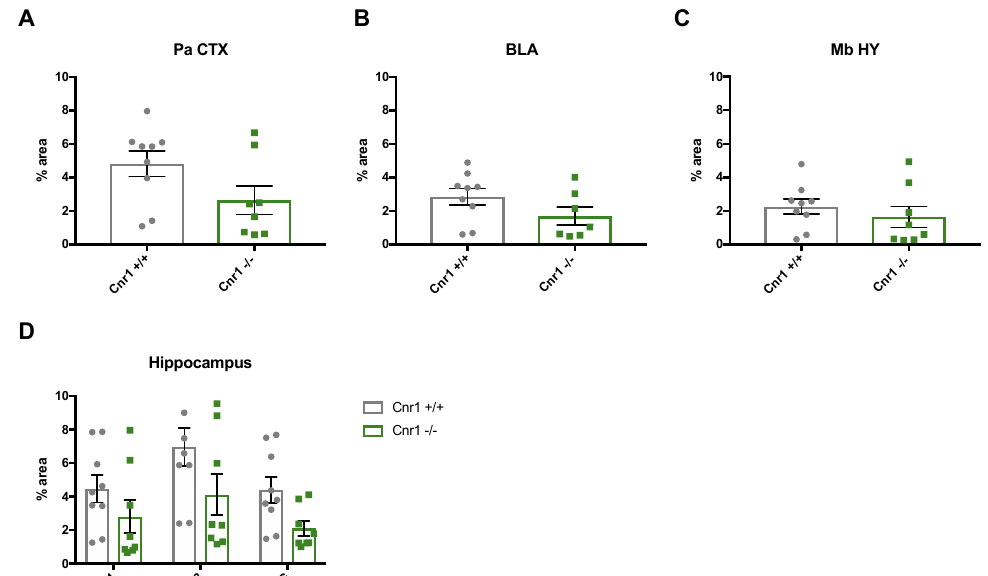
Figure 4. Analysis of the density of adrenergic axon terminals are covered by NET-positive signal intensity in the parietal cortex (Pa CTX), basolateral amygdala (BLA), mediobasal hypothalamus (Mb HY) and hippocampal cornu ammonis 1 (CA1), cornu ammonis 3 (CA3), and dentate gyrus (DG) regions of 18-month old Cnr1 +/+ and Cnr1 − / − animals. N = 7–9 per genotype; Dots represent single animals, columns represent mean values, error bars represent standard error of means (SEM). The density of the NET-positive signal differed significantly between the target re- gions (F (5,75) = 5.964; p = 0.0001), being the lowest in the Mb HY and the highest in the CA3 region of the hippocampus. There was no genotype effect in young (3-month-old) mice (F (1,9) = 0.005; p = 0.945) and no genotype x region interaction (F (5,45) = 0.130; p = 0.985). Importantly, we found a positive correlation between the number of TH-positive cells and the NET-positive axon densities in both genotypes in the Pa CTX, Mb HY, CA1 and CA3 regions: lower cell numbers were associated with reduced NET densities (Figure 5 and Table 1). Nevertheless, steady-state noradrenaline levels were not different between the genotypes in any of the brain regions tested: Pa CTX (t 10 = 0.275; p = 0.789), BLA (t 10 = 0.787; p = 0.450), Mb HY (t 9 = 1.694; p = 0.125), HC (t 10 = 0.776; p = 0.4554).